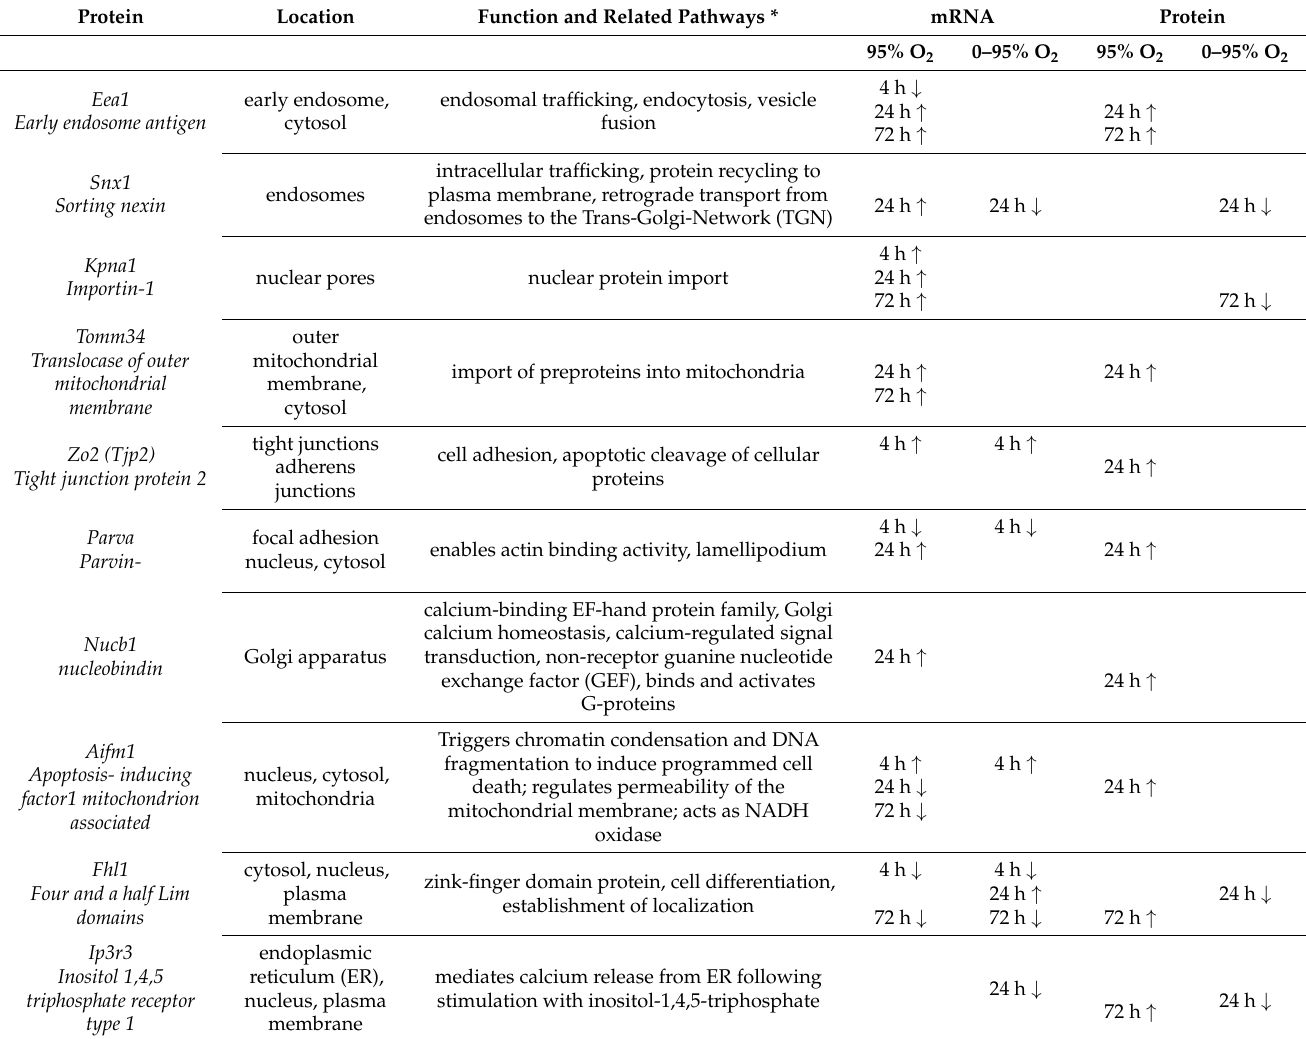
Table 4. Proteins identified as DEPs in proteomic analysis and selected for further quantification of mRNA expression at time points 4 h, 24 h and 72 h. Significant upregulation and downregulation of DEPs as determined by proteomic analysis (protein), and qRT-PCR (mRNA) is indicated by